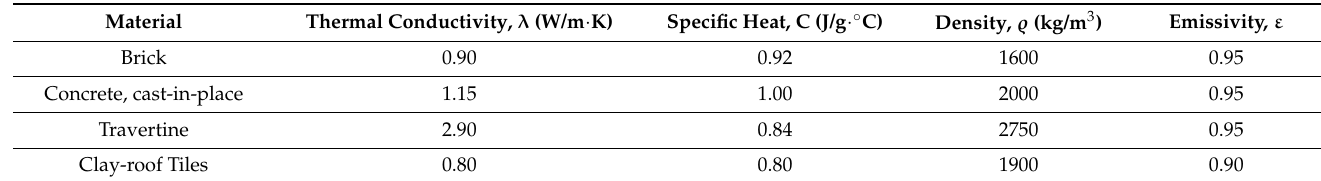
Table 1. Thermal variables of selected materials.